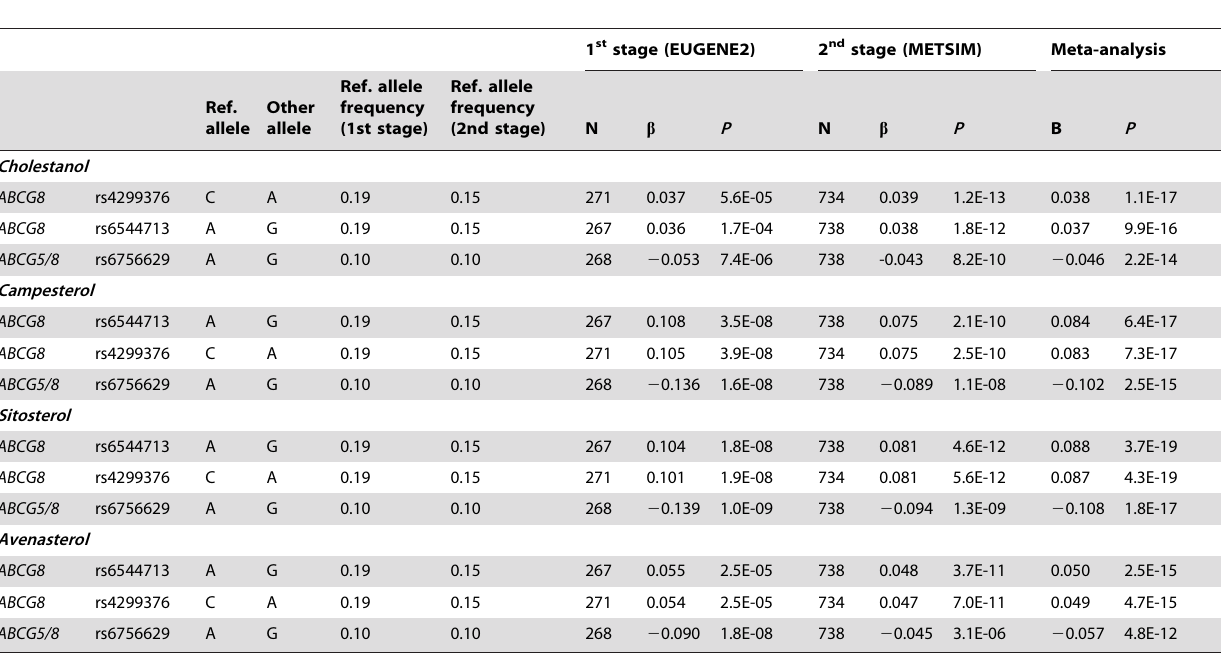
Table 5. Genotyping results: 1 st stage results obtained from genome-wide association study (EUGENE2 Study), 2 nd stage results obtained from replication study (METSIM Study), and meta-analysis of both